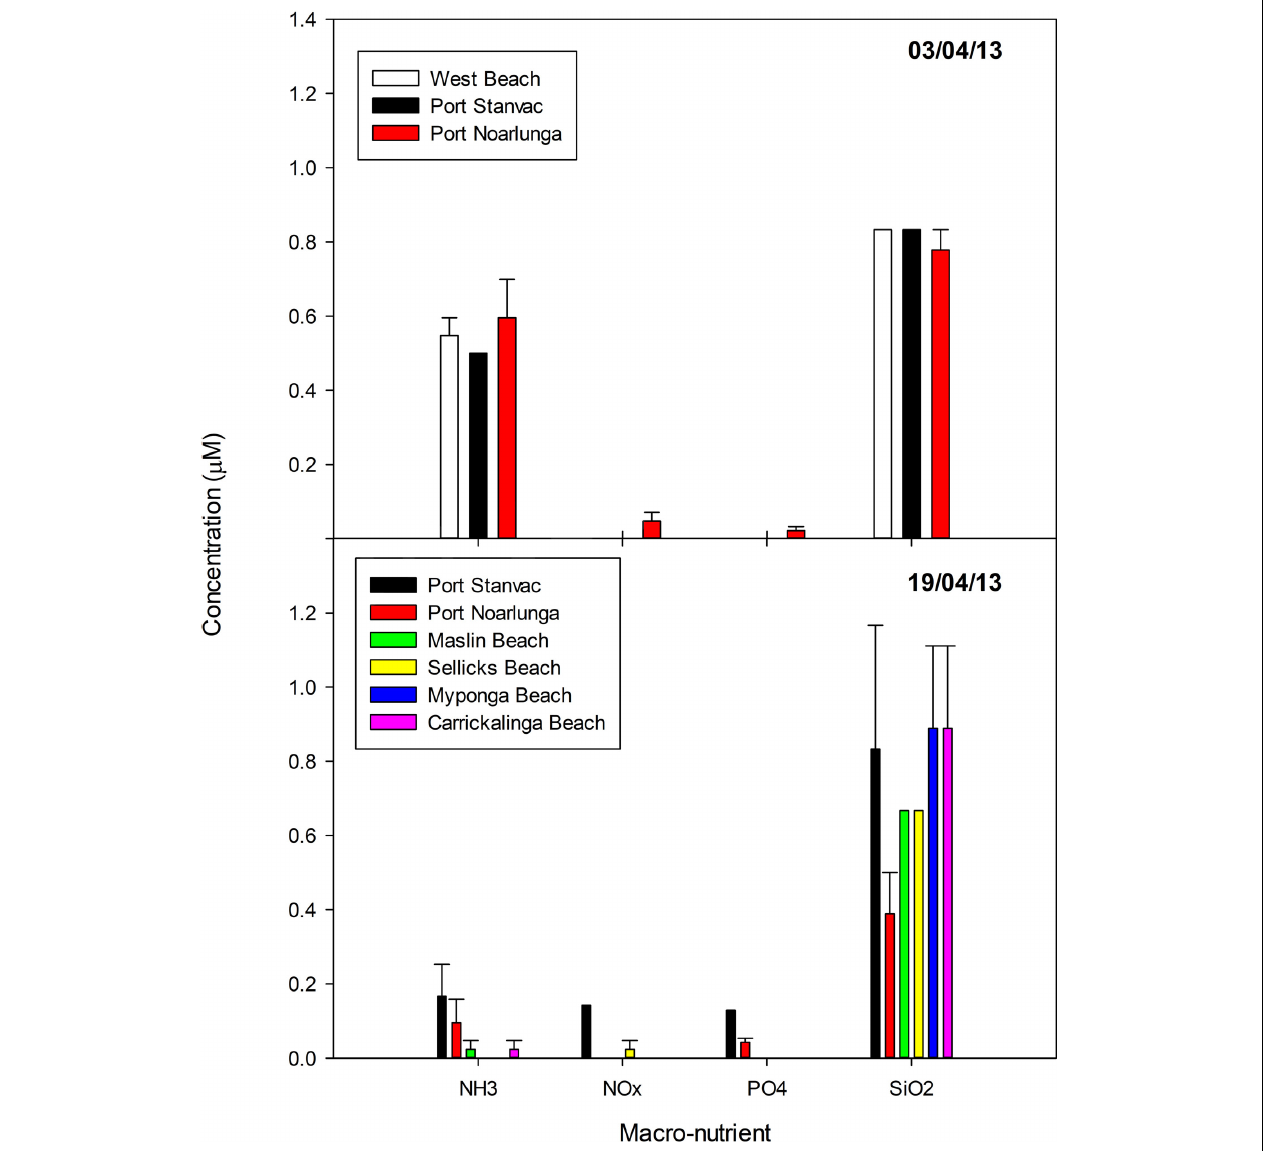
FIGURE 5 | Macro-nutrient concentrations in samples collected in Gulf St Vincent on 3 and 19 April 2013 (average ± standard error). Station locations are displayed in Table 2